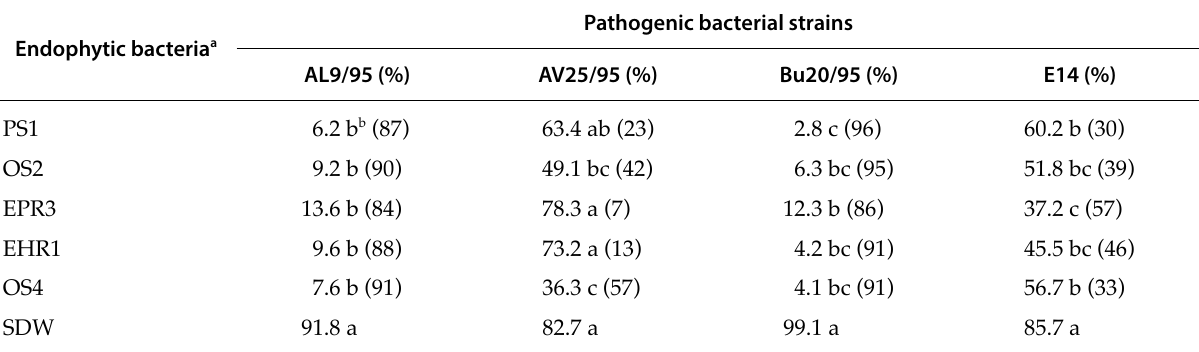
Table 3. Mean weights of tumours (mg) induced by Agrobacterium vitis and A. tumefaciens on stem-inoculated tomato plants root-treated with different endophytic